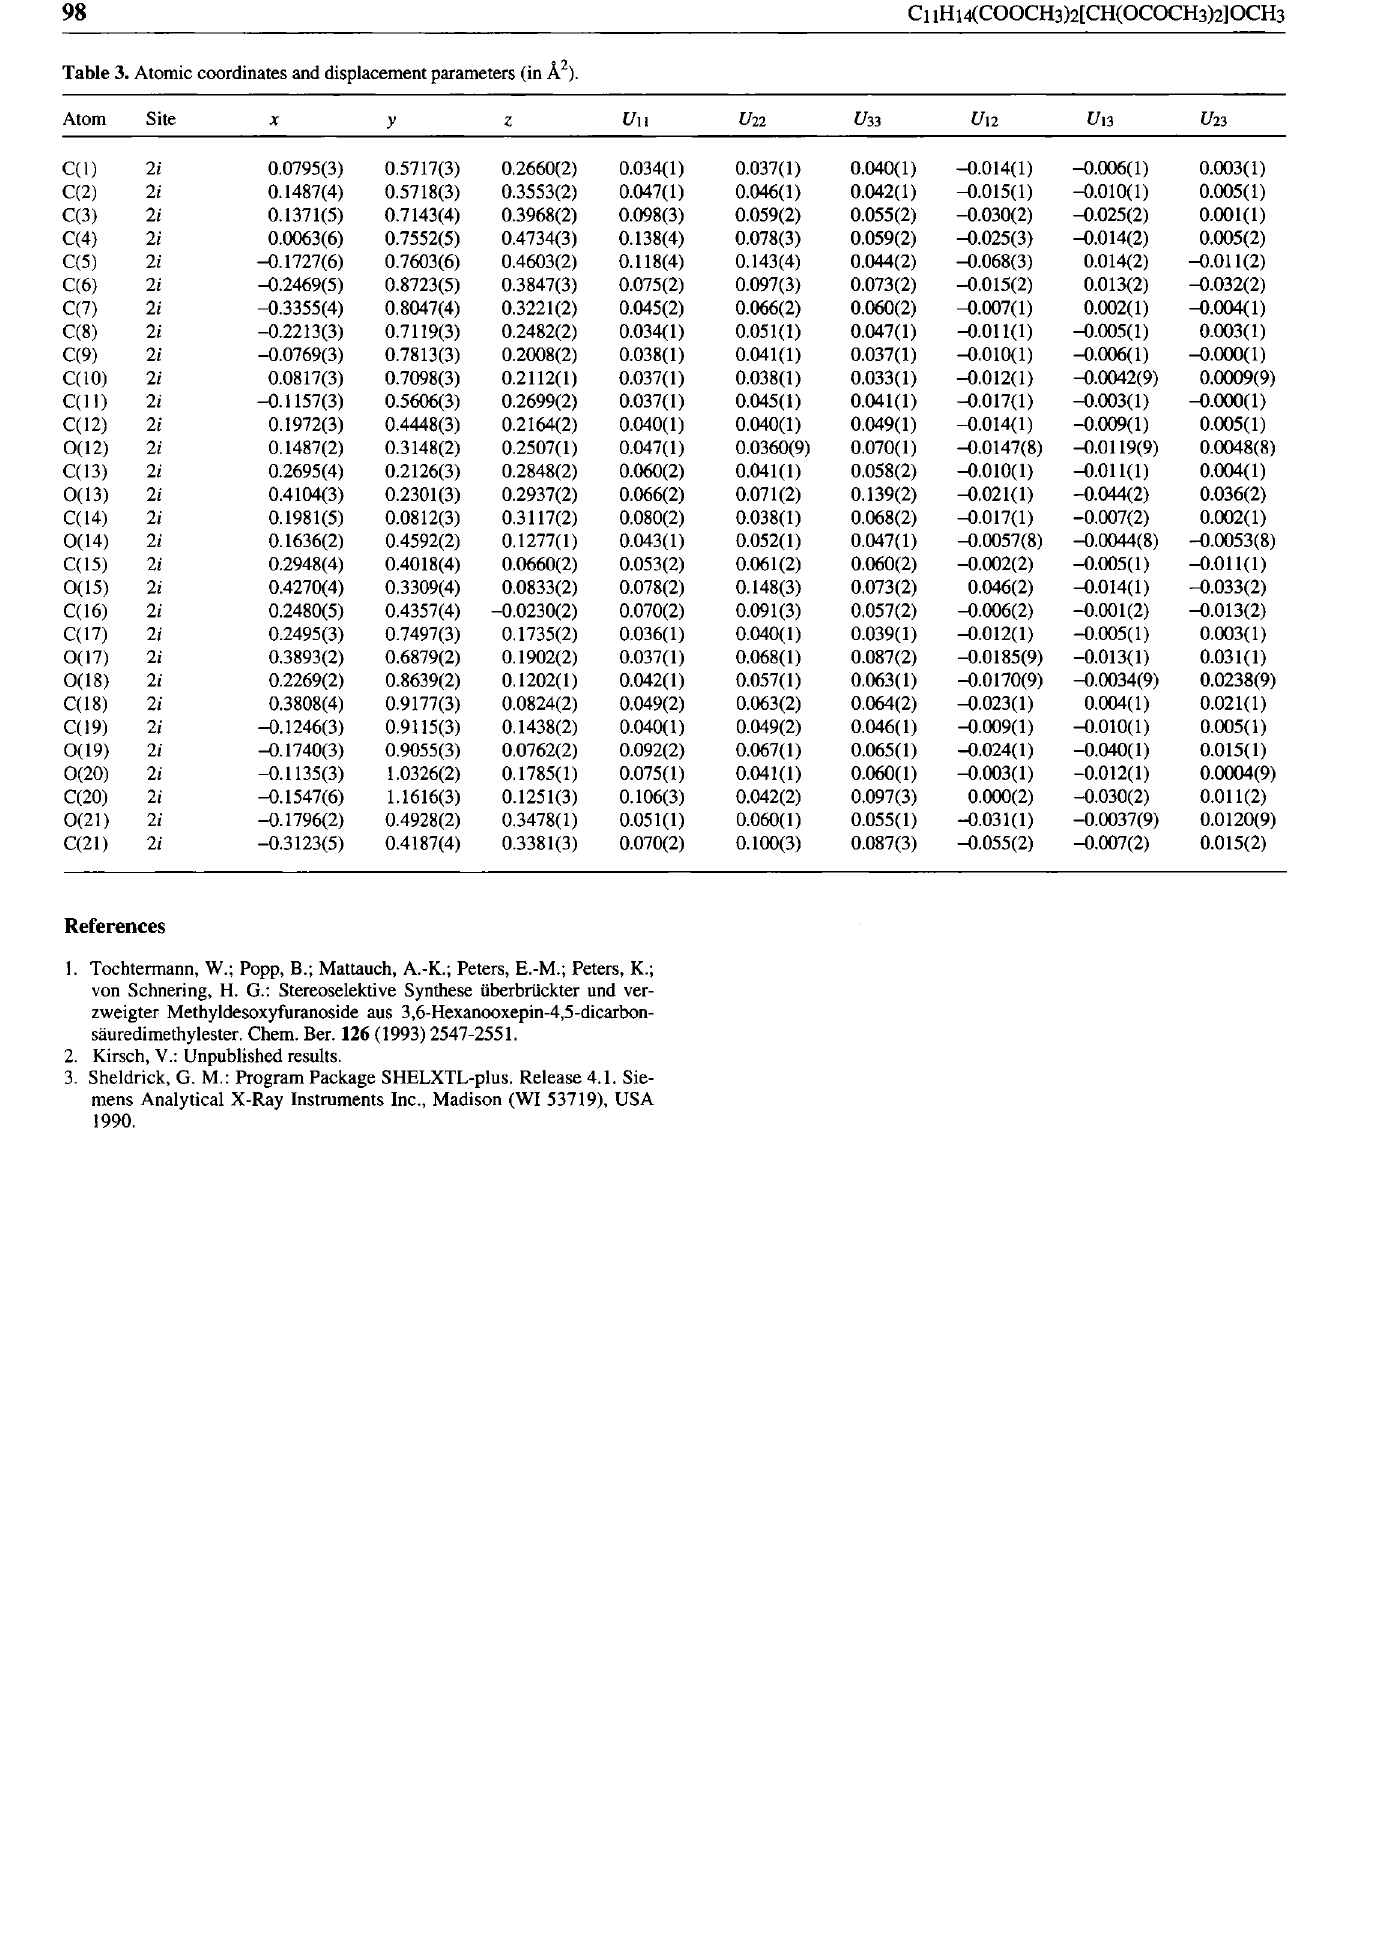
Table 3. Atomic coordinates and displacement parameters (in Â 2